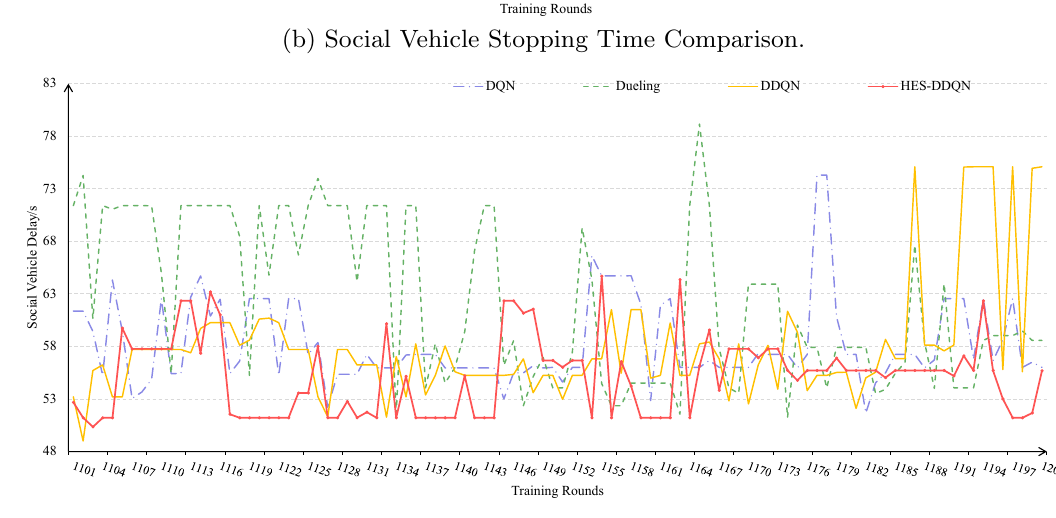
(c) Social Vehicle Queue Length Comparison. Fig. 8 Experimental results of HES-DDQN pre-signal timing model for the Zhuhai